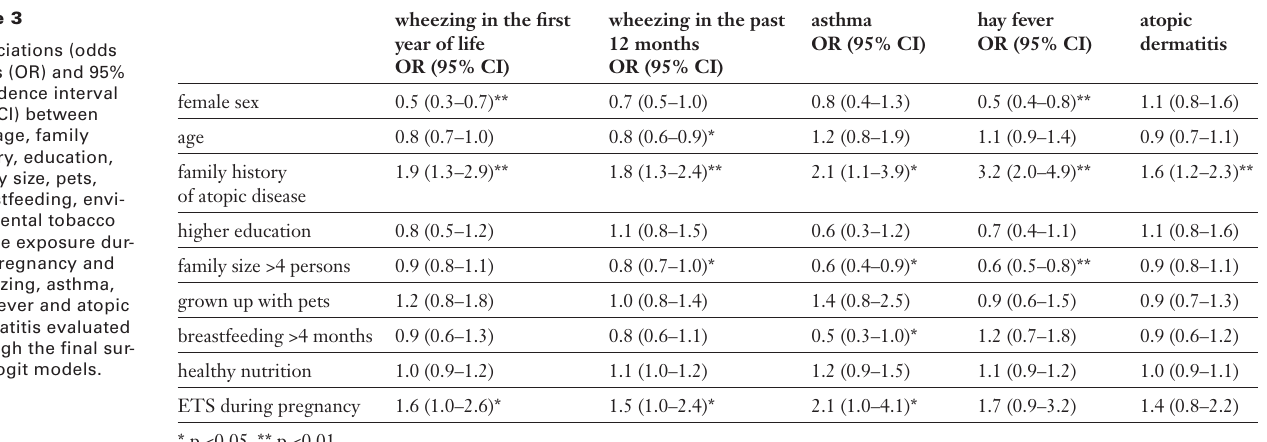
Figure 2 Nutritional habits during the past 12 months in currently smoking (n = 351) and non-smoking (n = 1366)